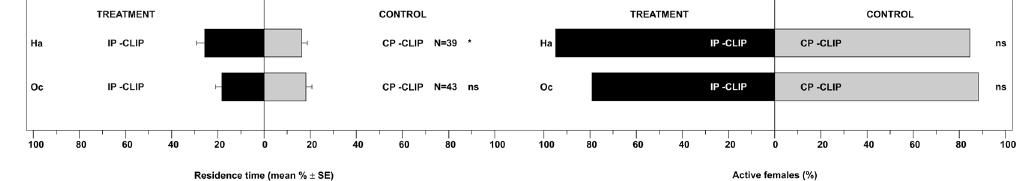
Figure 4. Residence time and active Harmonia axyridis and Oenopia conglobata females in each arm of the olfactometer connected with volatiles from the Vicia faba – Aphis fabae system. Odour treatments consisted of a locally infested plant obtained by exposing the surface of the 4th leaf to juvenile and adult aphids inside a clip cage (IP -CLIP). Control consisted of a clean V. faba plant with an untreated 4th leaf with a clip cage (CP -CLIP). Caged leaves were removed prior to the bioassays. N = number of replicates. * = P < 0.05; ns = not significant.